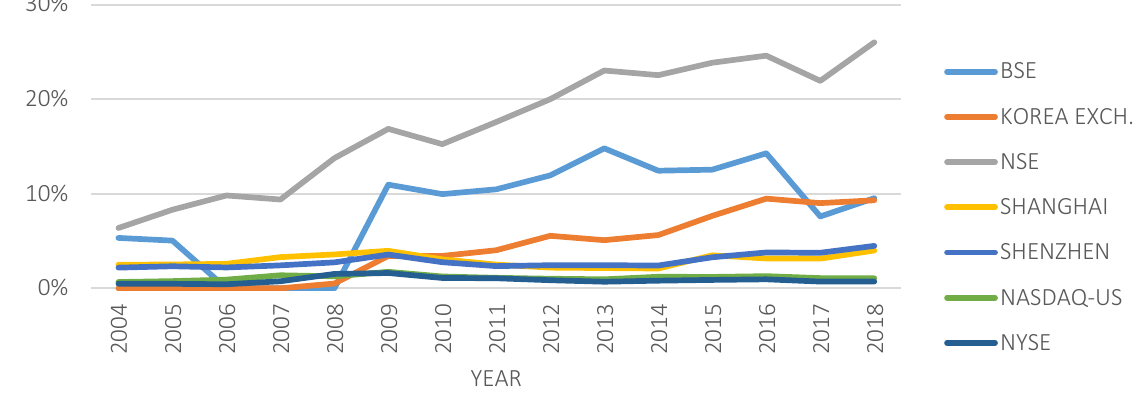
Figure 1. Trends in ω in 2004–2018 Table 3. Trends in ω from 2004 to 2018 in emerging Asian stock exchanges (in percent) Stock